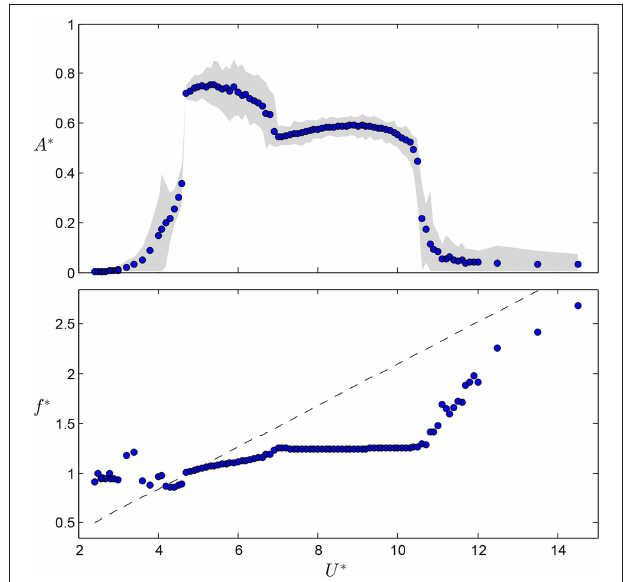
FIGURE 2 | Variation of the response amplitude, A ∗ , and frequency, f ∗ , with the reduced velocity, U ∗ .